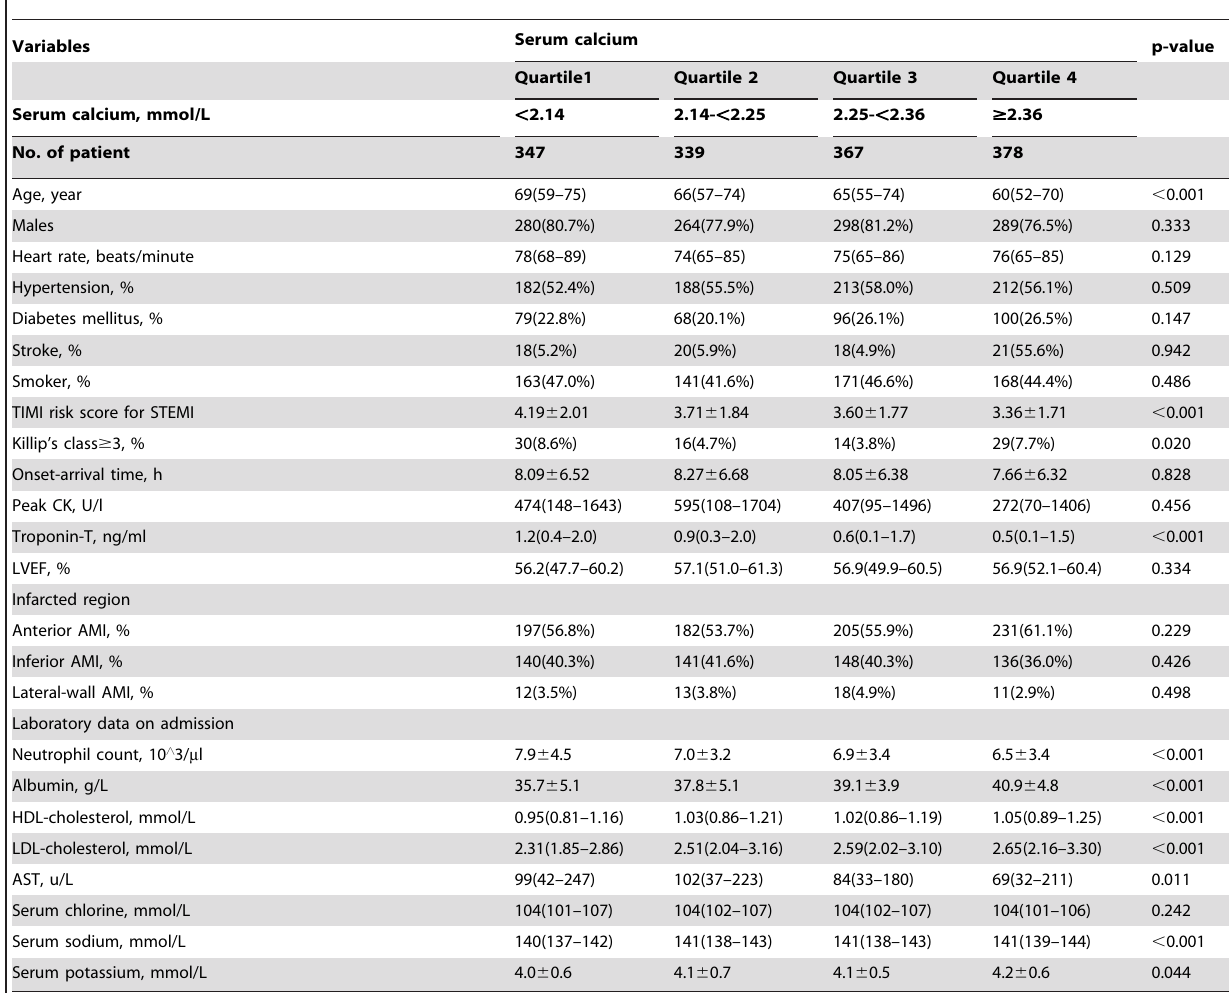
Table 1. Comparisons of the baseline characteristics of the STEMI patients according to serum